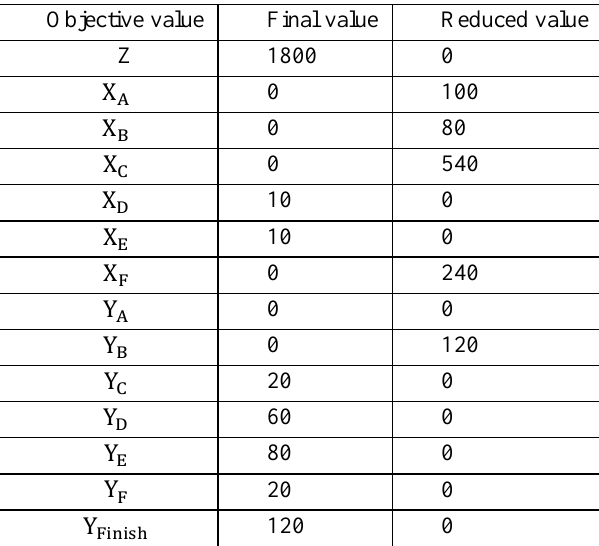
Table 5. Solution of the